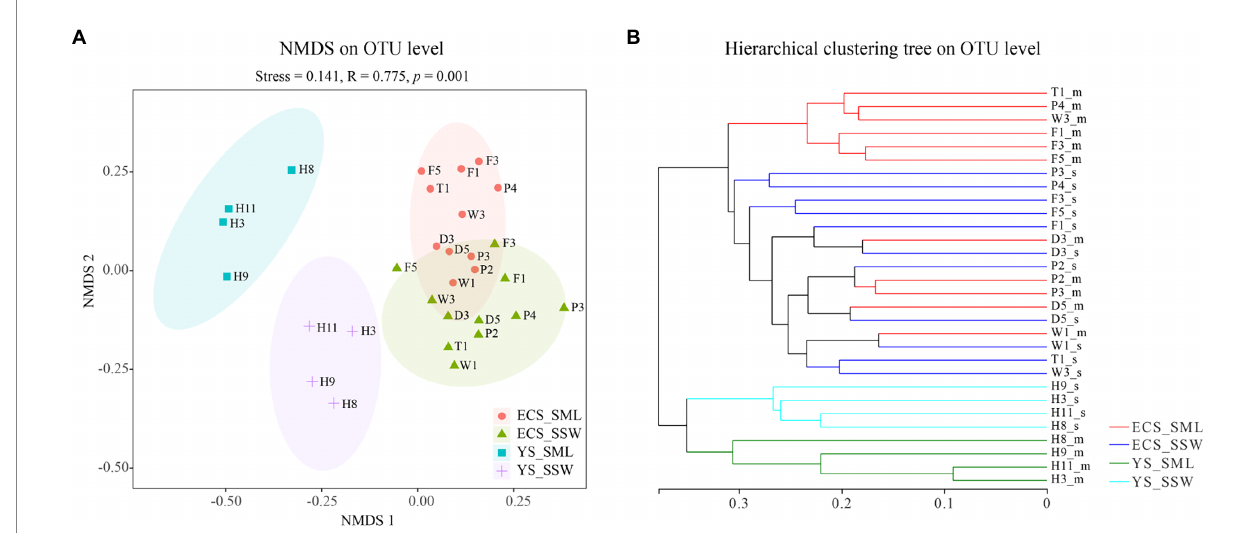
FIGURE 2 The NMDS analysis and hierarchical clustering tree of bacteria community of the SML and SSW in the eastern China marginal seas in summer. (A) , The NMDS analysis on OTU level; (B) , The hierarchical clustering tree on OTU level. ECS_SML, the East China Sea SML samples; ECS_SSW, the East China Sea SSW samples; YS_SML, the Yellow Sea SML samples; YS_SSW, the Yellow Sea SSW